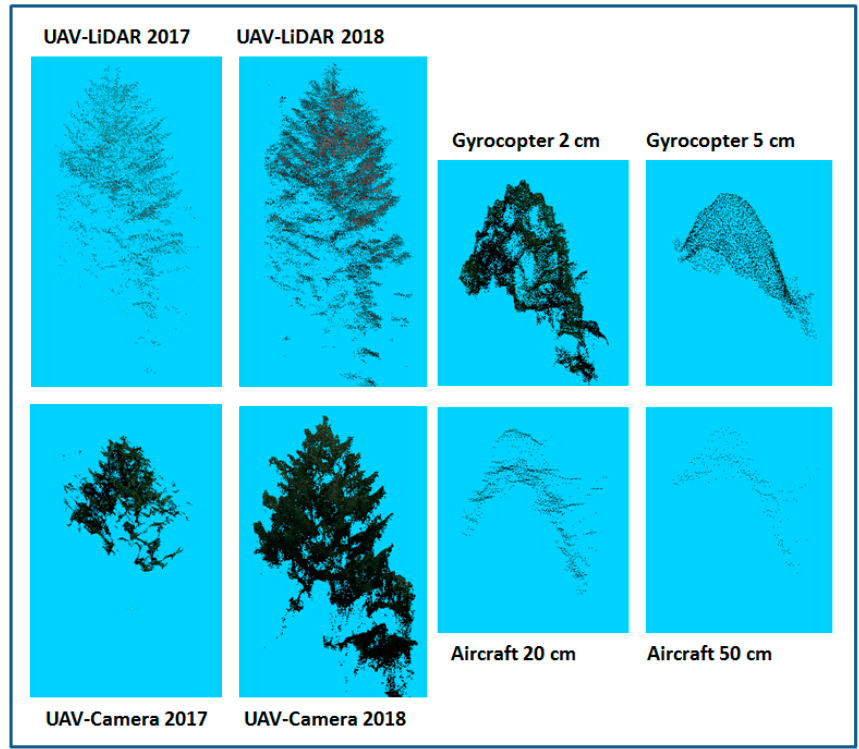
Figure 2. Comparison of the point clouds obtained from all remote sensing datasets. All point clouds show a single tree crown from the same